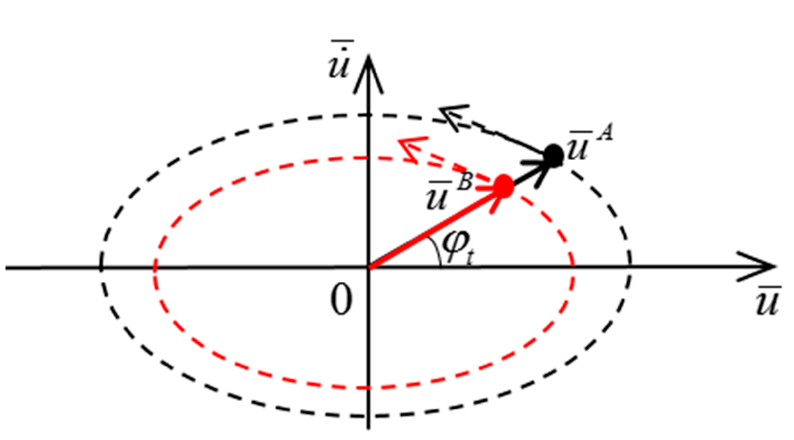
Figure 4. Phase plane curves of relative modal motions. As